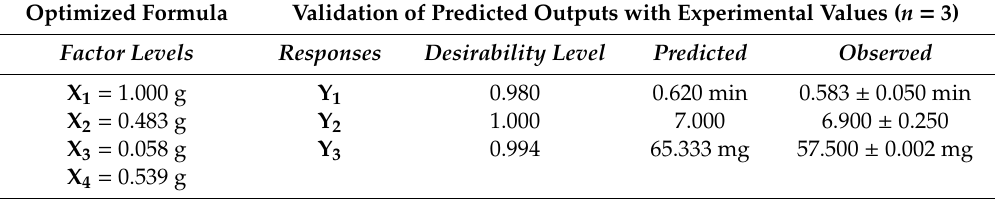
Table 2. Optimized formula and model summary of fitted and experimental outputs as it relates to the experimental design template.